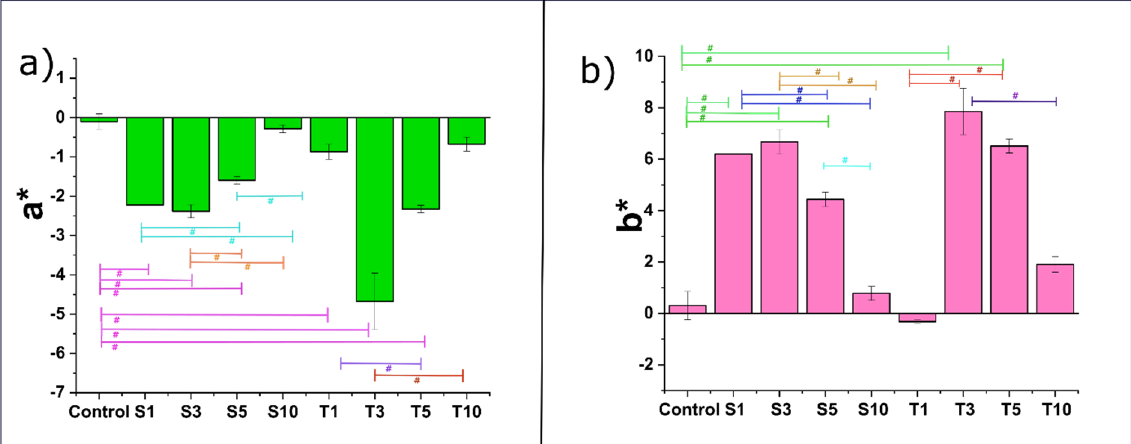
Figure 2. Colour parameters of the oleogels: ( a ) a* values; and ( b ) b* values. The values in the graph are denoted as the mean of the triplicate ± standard deviation ( p < 0.05) The significantly different values are represented with symbol #. The details of abbreviations used are provided in Section 4.2 (Table 5).